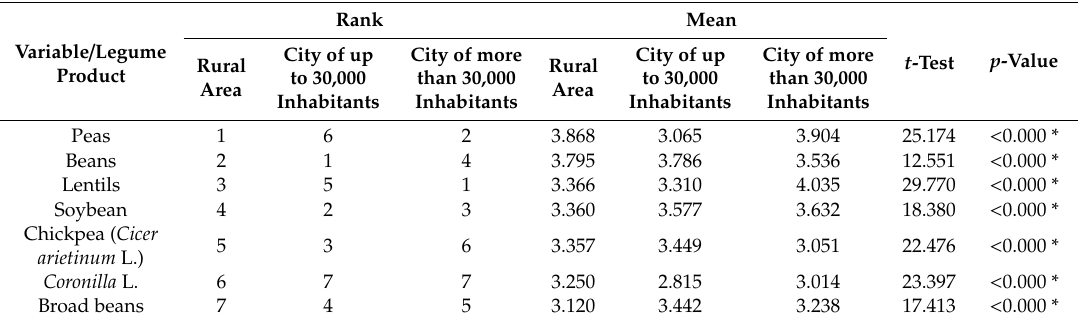
Table 2. Comparison of legume products desired by consumers in terms of the consumer’s place of residence. The consumer had at least three products to indicate.